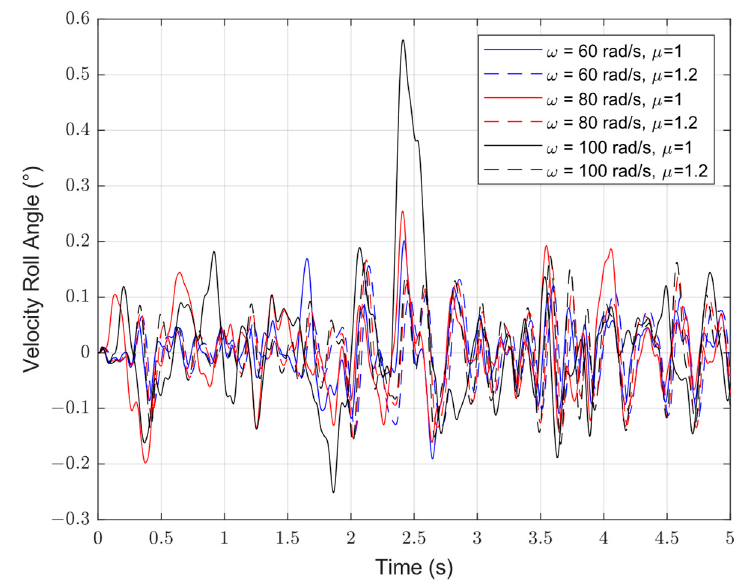
Figure 10. Response of Velocity Roll Angle with Measurement Noise. The blue, red and black dotted lines indicate the attack angle response of the system with an FOESO bandwidth of 60 rad/s, 80 rad/s and 100 rad/s and a fractional-order